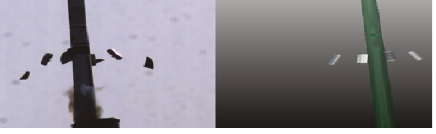
Figure 7: The comparison of experiment and simulation at 0.2445s.